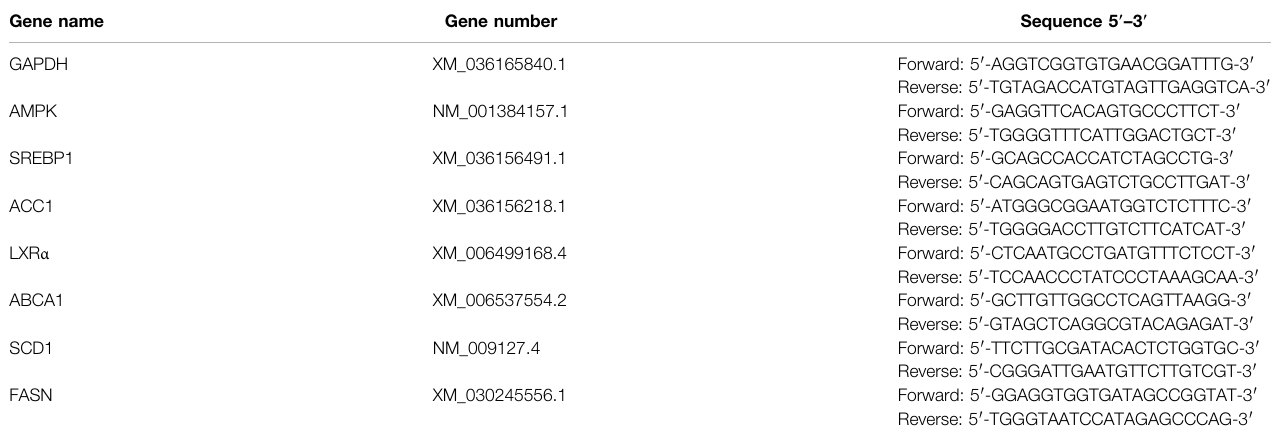
TABLE 1 | Primer sequences for quantitative real-time PCR ampli fi